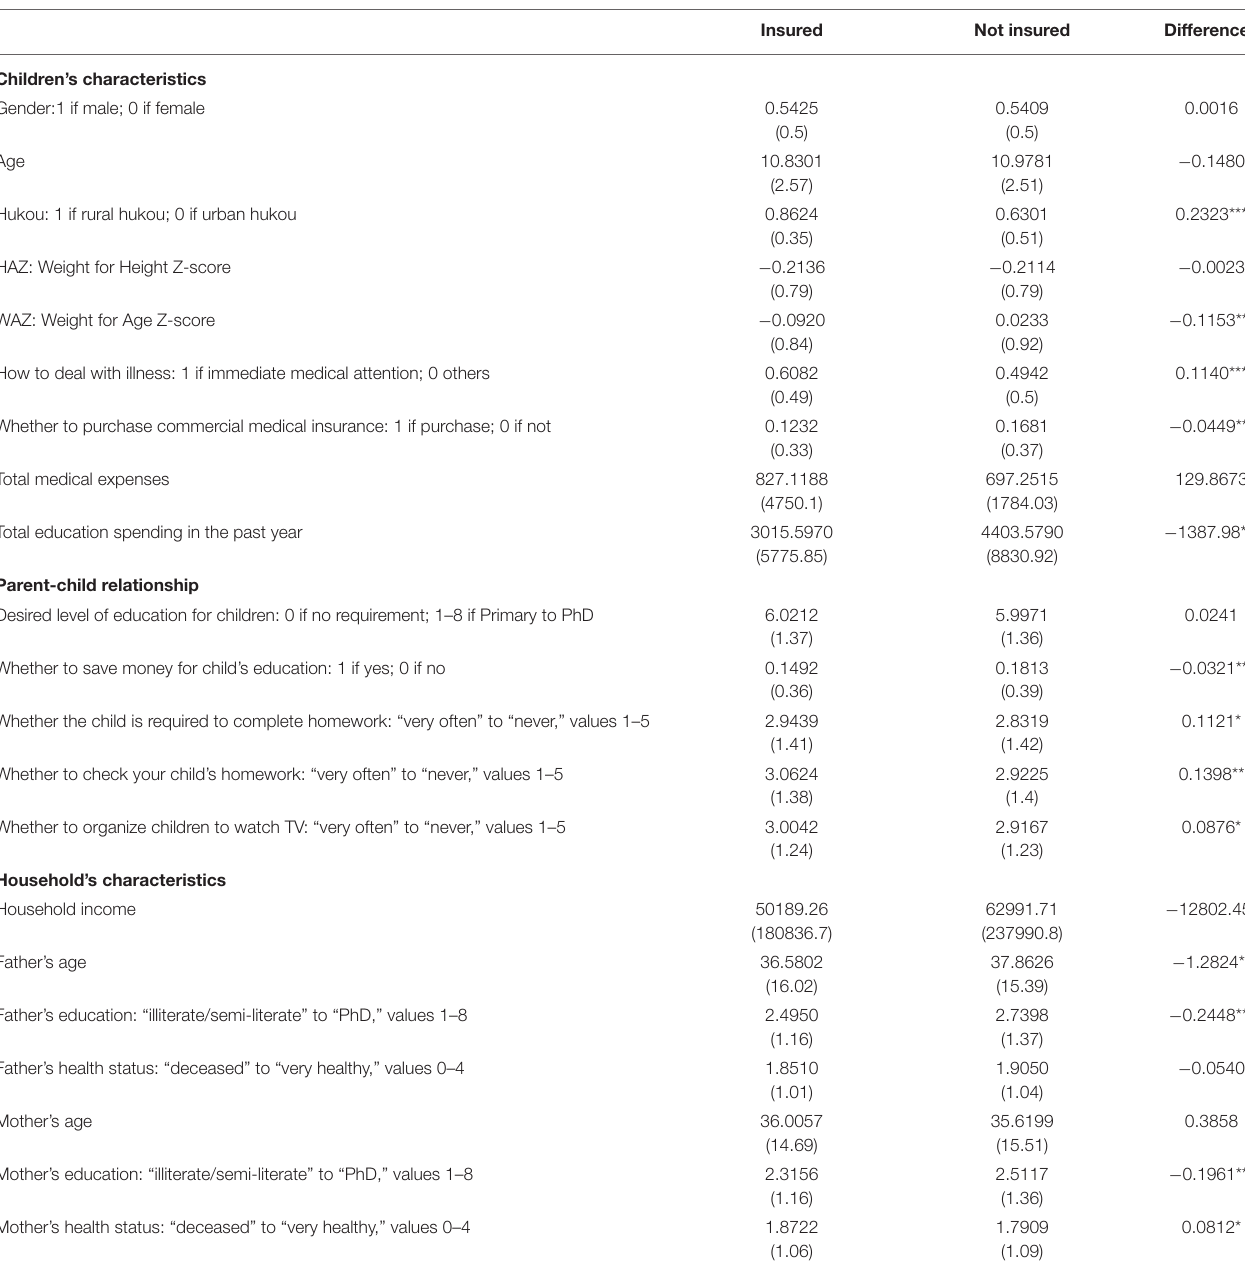
TABLE 2 | Description of covariates and descriptive